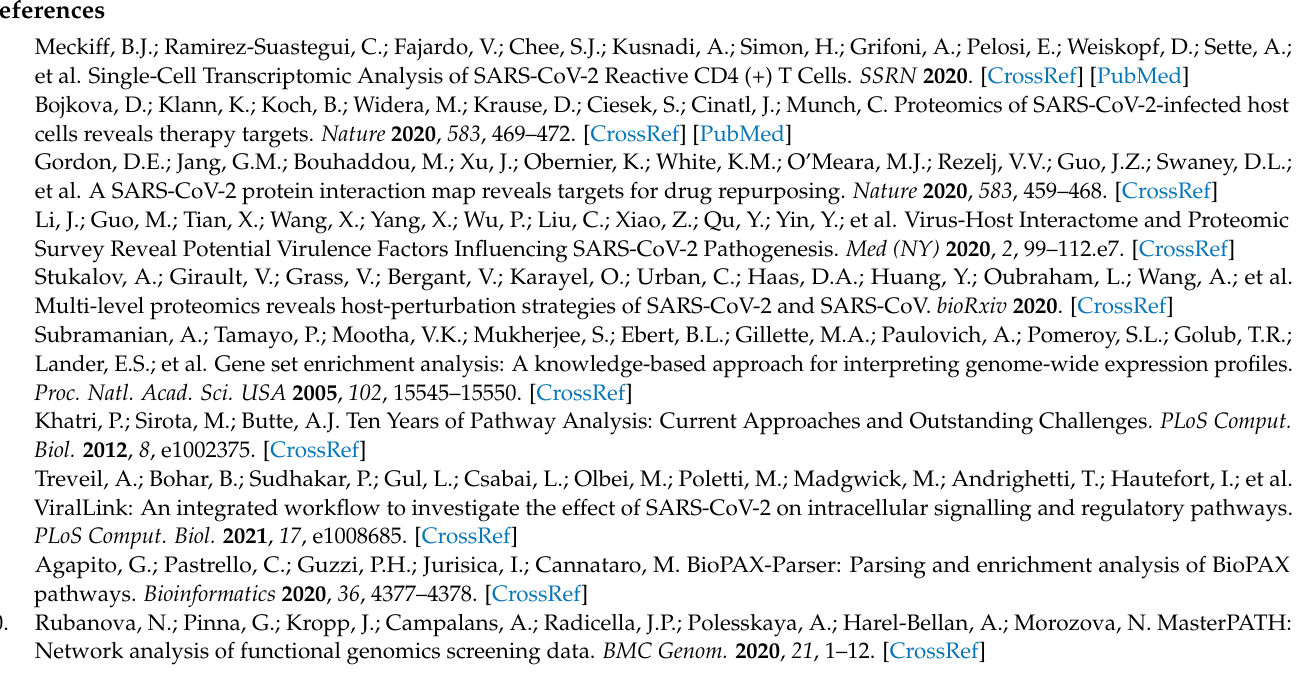
Table S1. List of the 75 SARS-CoV-2 interacting proteins. Table S2. Clue-GO enrichment analysis of the 75 SARS-CoV-2 interacting proteins. Table S3. List of the top 100 gene hits controlling autophagy. Table S4. Paths from the autophagy-related genes to SIGNOR 2.0 pathways. Only significant ( p -value < 0.01) paths have been shown. Table S5. Clue-GO enrichment analysis of the 100 gene hits regulating